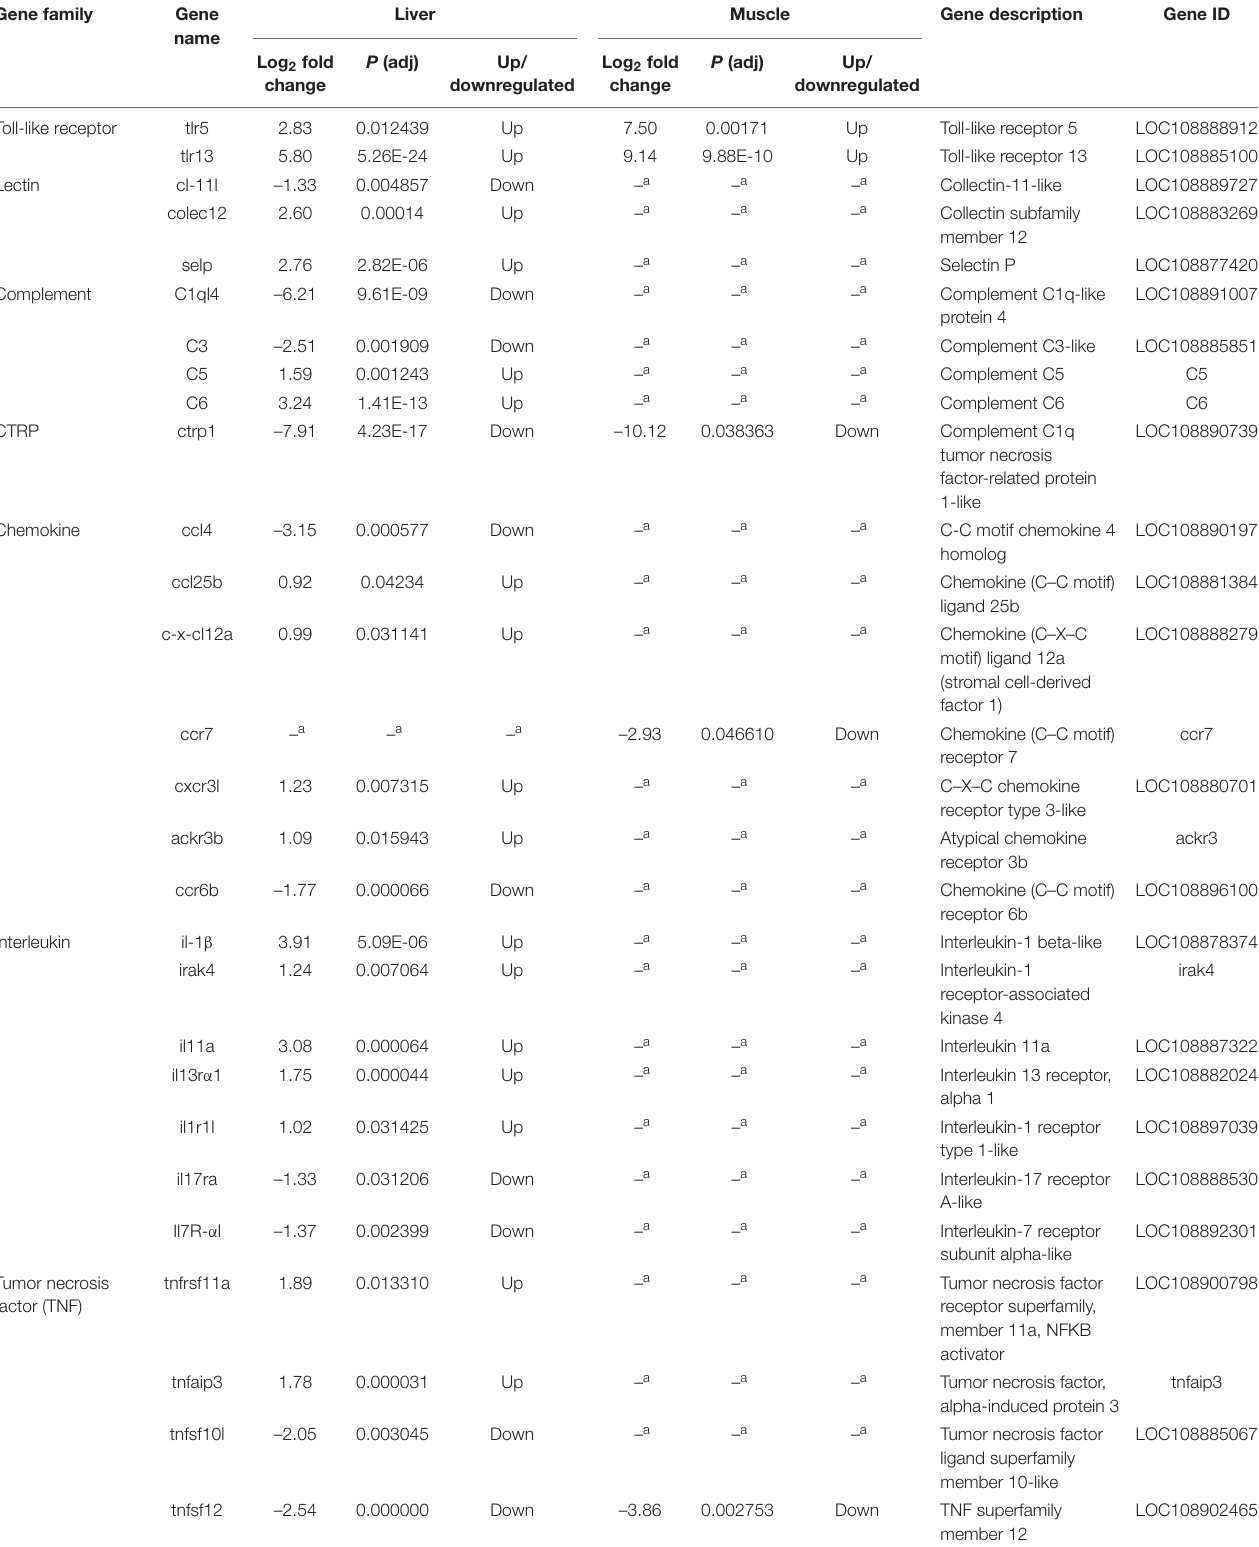
TABLE 5 | Summary of immune-relevant genes characterized from sick (vs. healthy) barramundi based on KEGG functional analysis. Gene